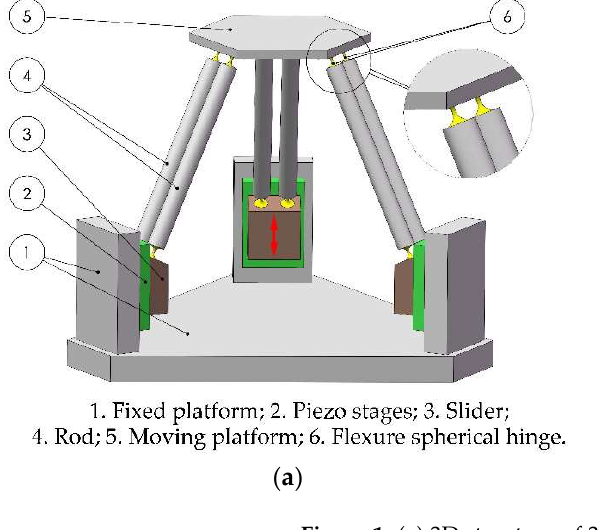
Figure 1. ( a ) 3D structure of 3-PSS flexible parallel micromanipulator; ( b ) simplified pseudo-rigid body model and coordinate frame